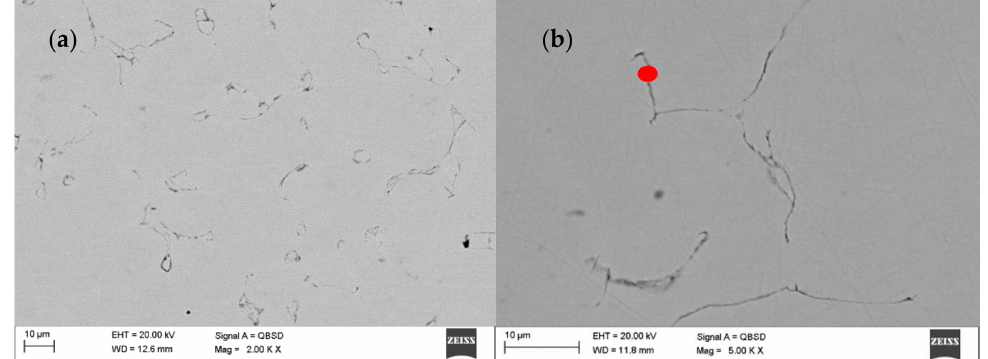
Figure 5. ( a ) Scanning electron microscope (SEM) image of the central part of sample after debinding under Ar-5%H 2 and sintering at 1350 ◦ C under Ar-5%H 2 ; ( b ) SEM image of the central part of sample after debinding under Ar-5%H 2 and sintering at 1350 ◦ C under Ar-5%H 2 .